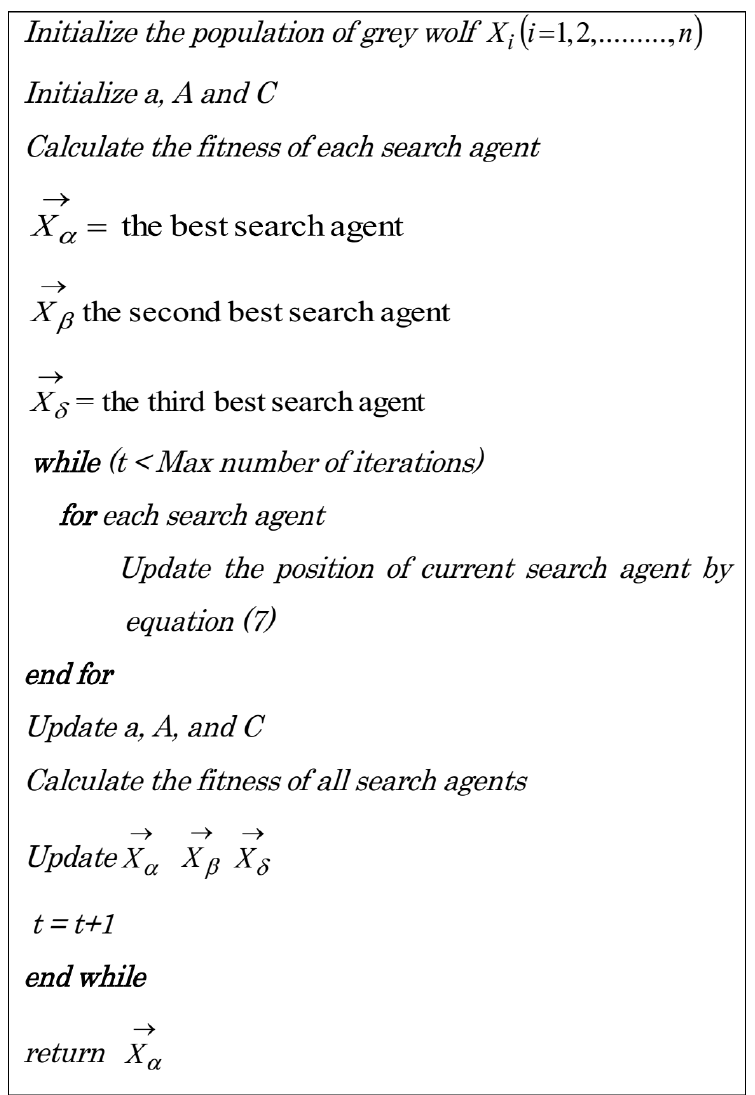
Figure 1. Pseudo code of the GWO